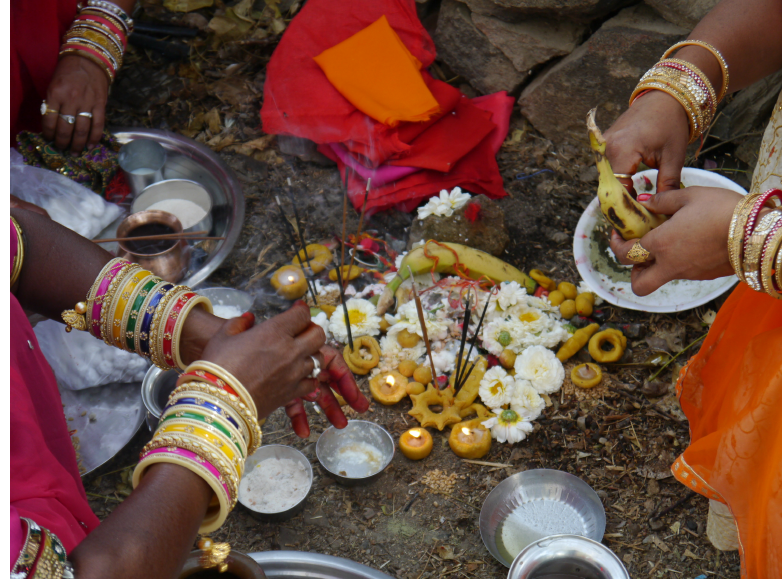
Figure 4. Women beautifying mother soil with gifts of gold—photo by Notermans, March